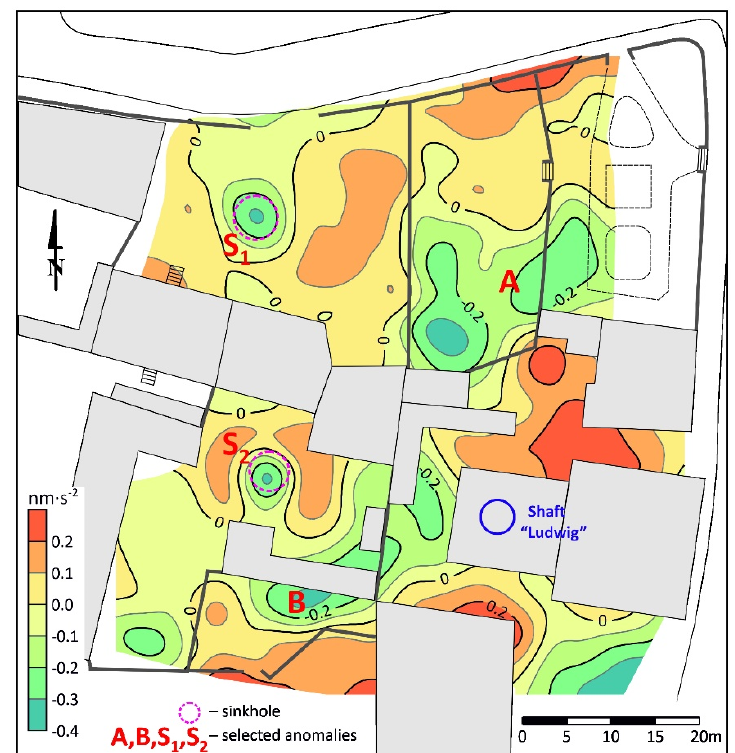
Figure 11. Distribution of residual anomalies.